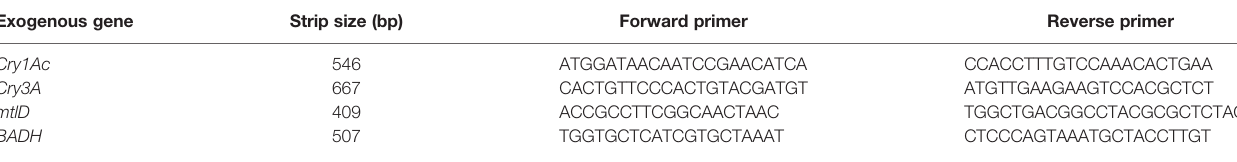
TABLE 1 | PCR primers for exogenous